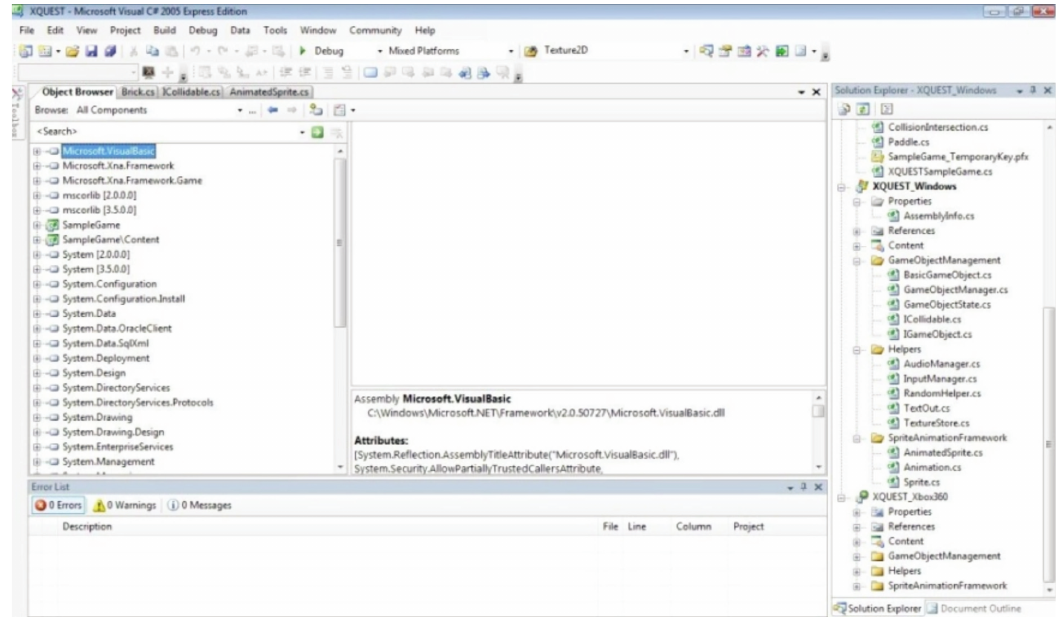
Figure 2: The XQUEST library shown in the XNA development